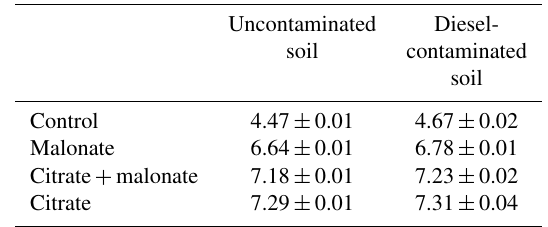
Table 2. Soil pH (CaCl2) after an 18-day incubation of diesel- contaminated and uncontaminated soils which received water or 5µmolg − 1 soil of malonate, citrate + malonate, or citrate every 48h. Values are means ± SE ( n = 3). There was an interaction be- tween carboxylate addition and diesel contamination ( P = 0.001; LSD 0 . 05 = 0.055). Initial soil pH was 4.6, and carboxylate solution pH was